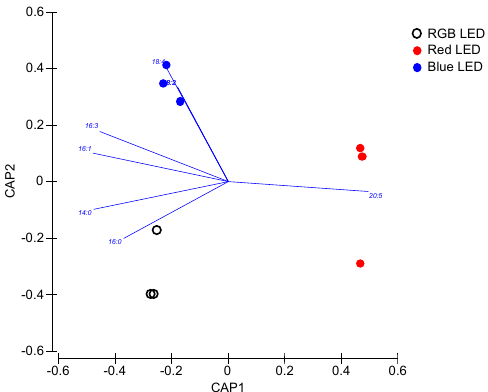
Figure 10. Canonical Analysis of Principal (CAP) components of the P. tricornutum cultures ( N = 5) subjected to the three light treatments, having as basis the TAG fatty acid profile (relative concentrations) at the end of the 96 h exposure period (100% classification efficiency).